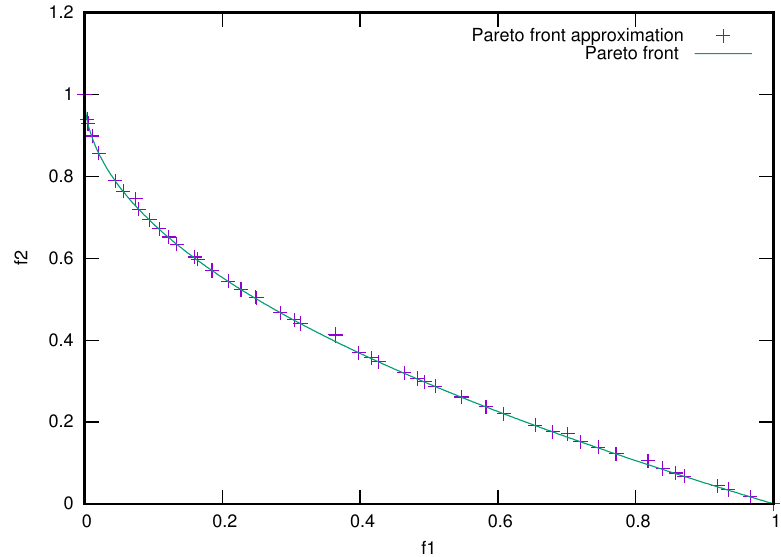
Figure 1. Example of Pareto front approximation of a multi-objective optimization